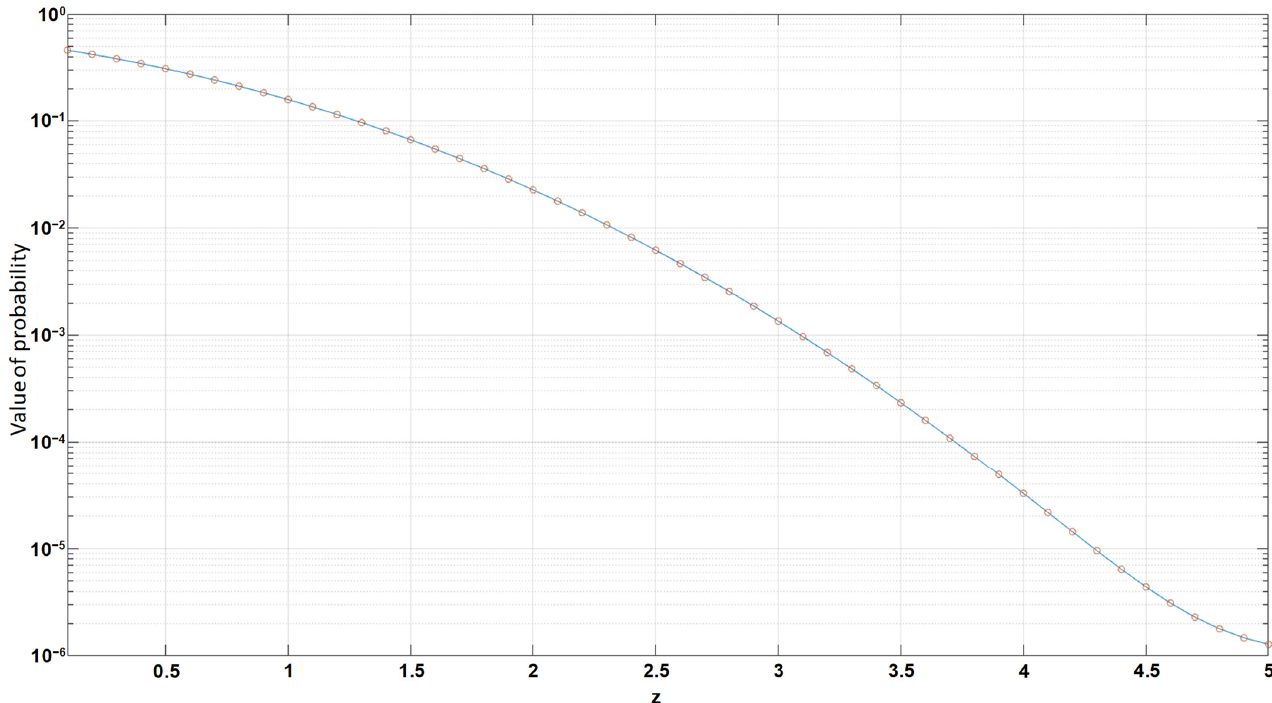
Figure 5. Dependence of error probability on signal to noise ratio threshold.